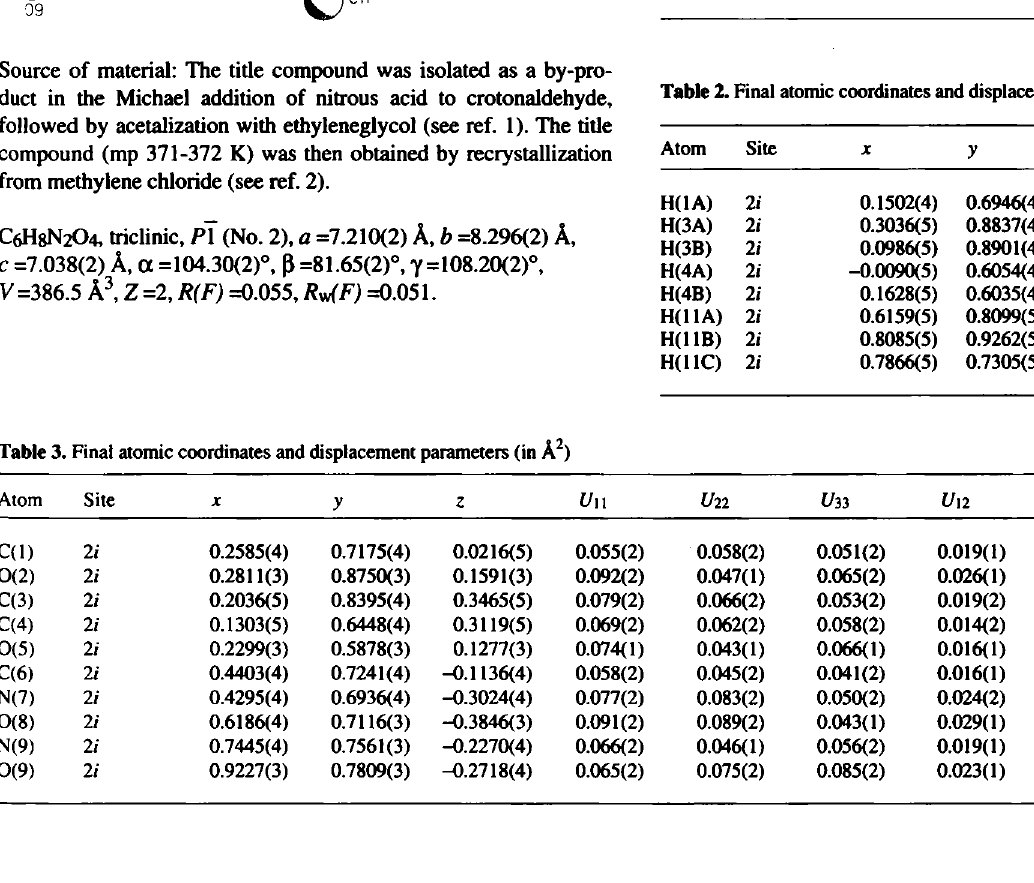
Table 2. Final atomic coordinates and displacement parameters (in À 2 )